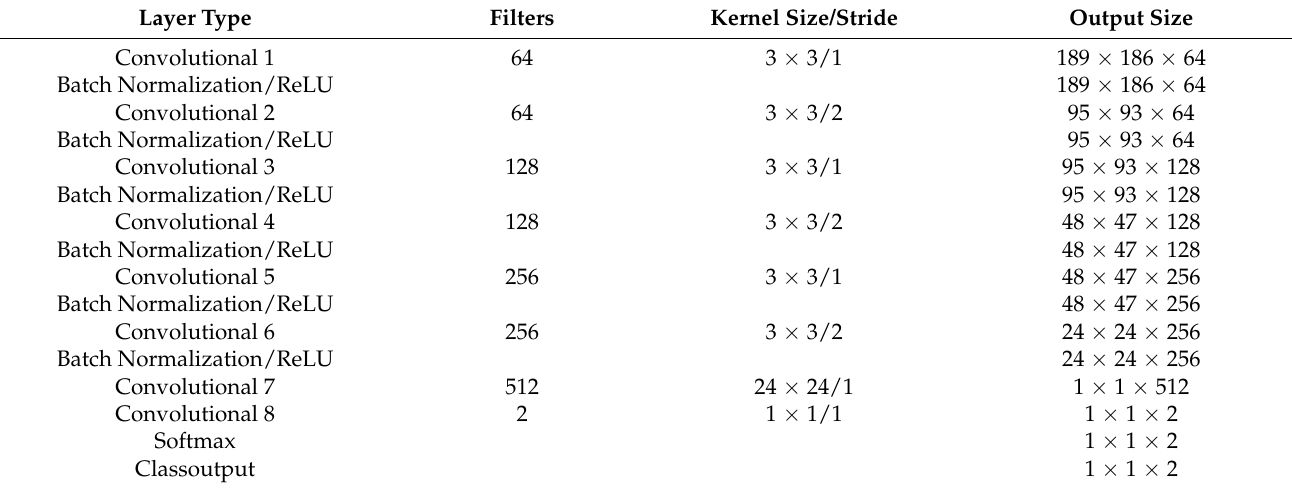
Table 3. Customized design model architecture.